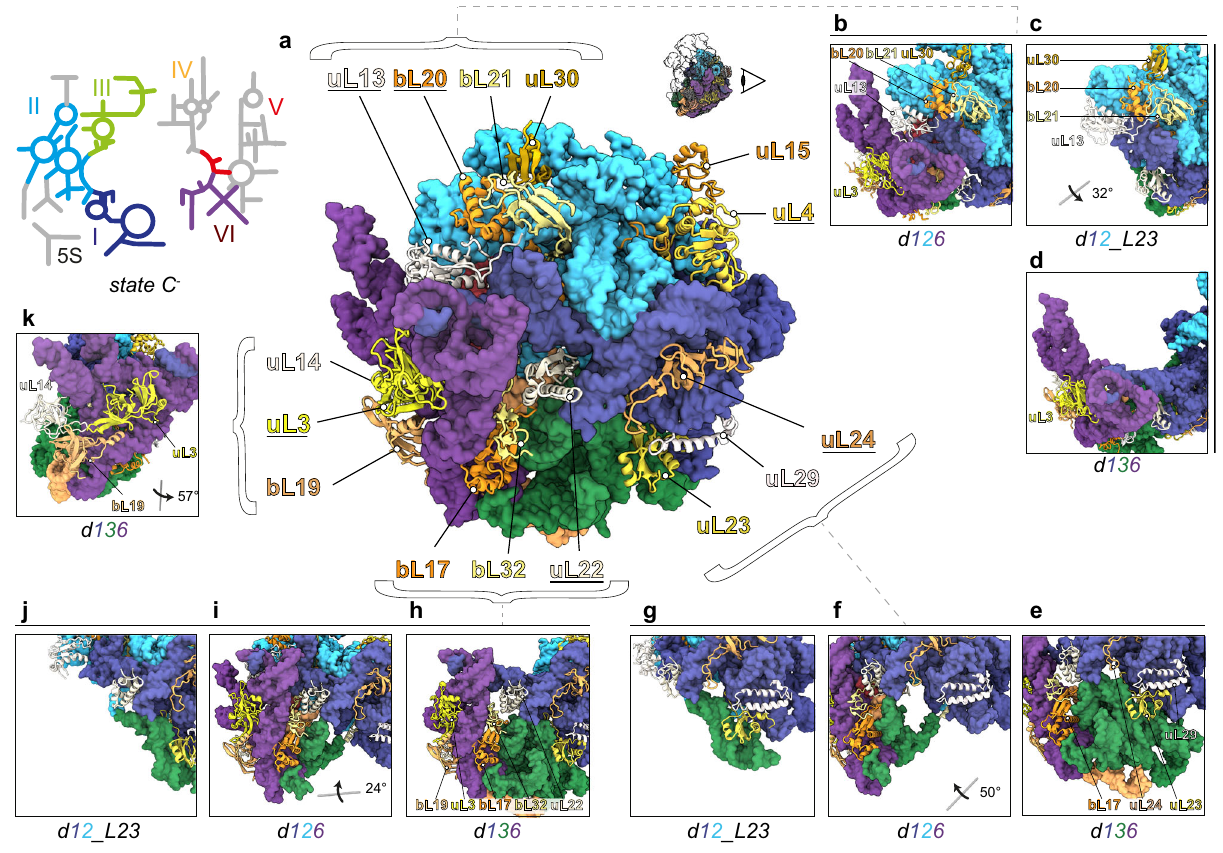
Fig. 2 | Clustering of L-proteins. a 2D rRNA map and atomic model of state C - in back view. L-proteins appear as cartoons (early essential proteins and uL3 are underlined), rRNA as surface model (lowpass- fi ltered to 5Å resolution). Presence and absence of bL21, bL20, and uL30 in states d126 ( b ), d12 ( c ), and d136 ( d ),